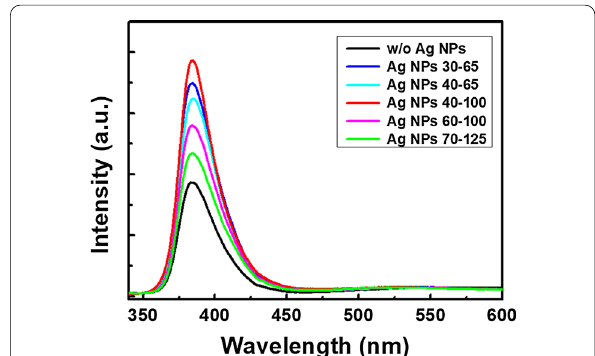
Fig. 4 PL spectra of samples with different diameters and spaces at room temperature